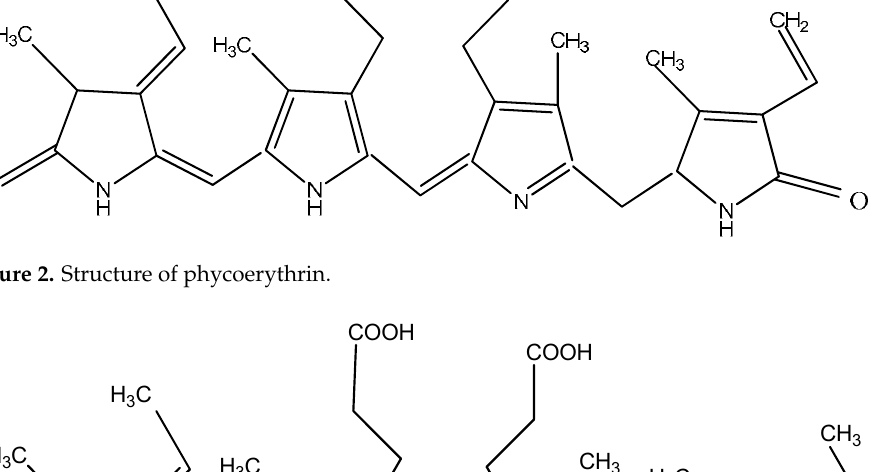
Table 2. Industrial application of bioactive compounds produced by red microalgae.